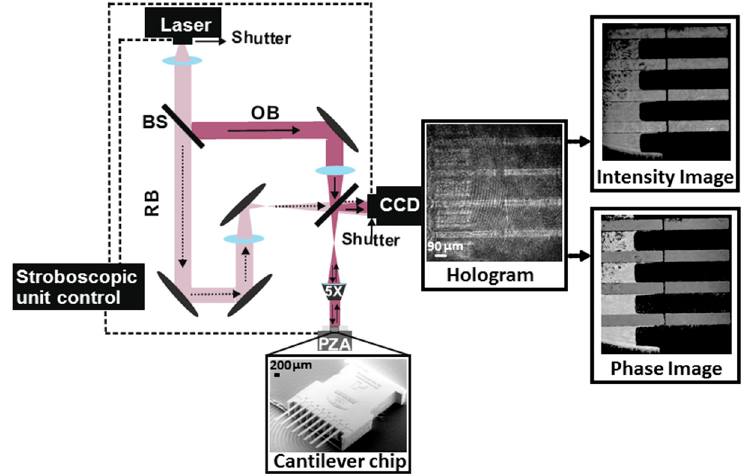
Figure 1. In a R-DHM, a coherent laser beam is split into the OB and the RB. The OB, which is the light reflected off the MCSs interferes with the RB on the CCD camera to form holograms. The phase and intensity images are extracted from the holograms. With the addition of the stroboscopic unit control, the time synchronization between three components of (1) the positions of the piezoelectric actuator (PZA) vibration, (2) the ON-time of the stroboscopic source (laser) pulse, and (3) the CCD camera shutter are controlled. The phase images are used to calculate the amplitudes of the vibrations. The measurements are performed in a closed chamber and through an optical window. The cantilever chip image shown at the bottom as mounted on top of the piezoelectric actuator is taken with a scanning electron microscope.